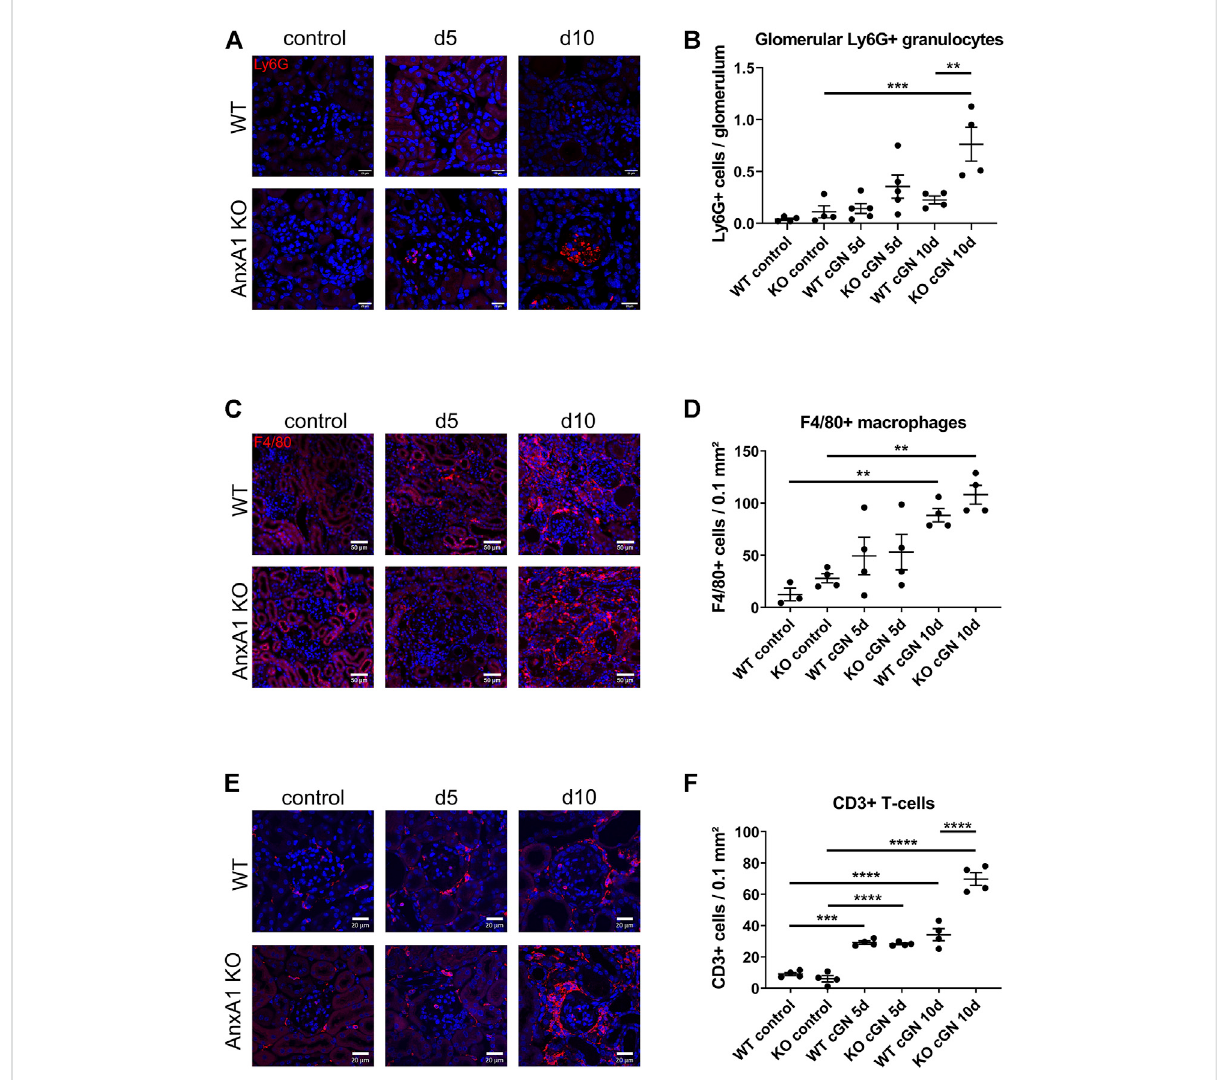
FIGURE 5 De fi ciency of annexin A1 increases the renal abundance of neutrophils, T-lymphocytes and macrophages. (A) Representative images of kidney sections from control wildtype (WT) and annexin A1 (AnxA1)-de fi cient mice (KO) and from mice at d5 and d10 after injection of normal sheep serum (control) or induction of crescentic glomerulonephritis (cGN). Sections were stained for Ly6G as marker for neutrophil granulocytes (red). (B) Quanti fi cation of glomerular granulocytes shows an increased abundance of Ly6G-positive cells in KO mice at d10 after cGN induction as comparedtothenephriticWTmice. (C) RepresentativeimagesofkidneysectionsfromcontrolWTandKOmiceandfromanimalsatd5andd10after cGNinduction.Sectionswerestainedfor F4/80 as markerfor macrophages(red).F4/80 positive cells accumulate intherenal interstitium ofWT and KO animals at d10 after cGN induction. (D) Quanti fi cation of renal macrophages shows an increased abundance of F4/80 positive cells at d10 after cGN induction without difference between the genotypes. (E) Representative images of kidney sections from control WT and KO mice and from animals at d5 and d10 after cGN induction. Sections were stained for CD3 as marker for T-lymphocytes (red). (F) Quanti fi cation of renal T-lymphocytesshowsasigni fi cantlyincreasedabundanceofCD3-positivecellsintheAnxA1-de fi cientmiceatd10aftercGNinductionascompared to the nephritic WT mice. Scale bar = 20 μ m in A,E and 50 µm in C, blue signal marks DAPI-stained nuclei. Dots in B,D, and F represent values from individual mice; horizontal lines indicate meanvaluesand error barsrepresent the SEM.Statisticalsigni fi cance of changes wascalculated